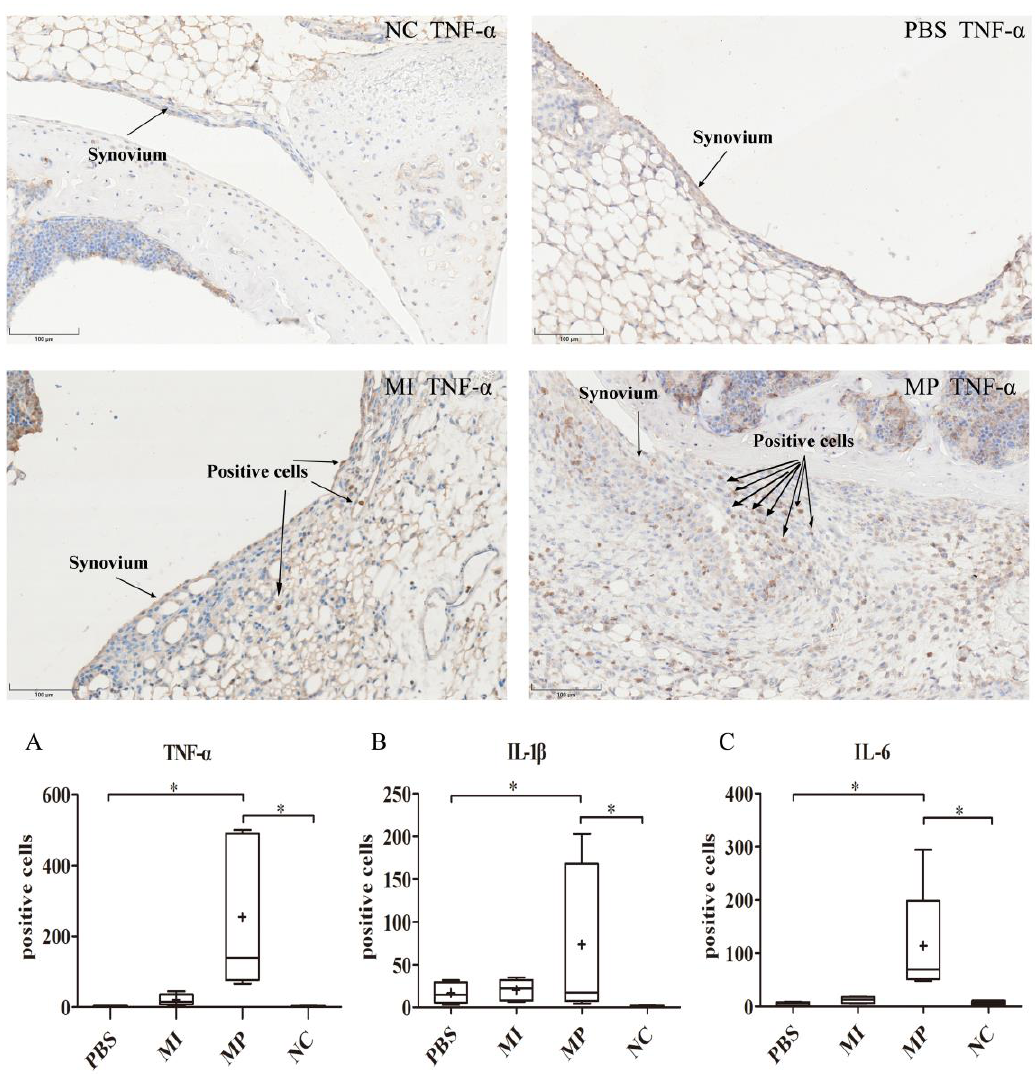
Figure 1. Expression of inflammatory markers (IL-1 β , IL-6 and TNF- α ) in the synovial layer of left murine knees. The staining results of TNF- α in the negative control (NC), phosphate-buffered saline (PBS), metal ion (MI) and metal particles (MP) group. Both the strongest expression and a thickened synovial layer are found in the MP group. ( A ) The expression of TNF- α in the synovial layer of left murine knees. ( B ) The expression of IL-1 β in the synovial layer of left murine knees. ( C ) The expression of IL-6 in the synovial layer of left murine knees. The staining results of IL-1 β , TNF- α and IL-6 are consistent. The MP group had the strongest inflammatory reactions. (Magnification: 200x; * p < 0.05).